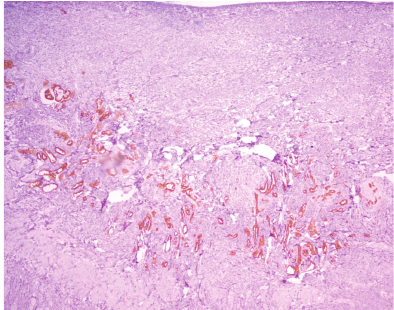
Figure 1: Low-power view of infiltrating malignant mesothelial tubular structures abutting the scrotal wall at the level of tunica dar- tos in close proximity of the epididymis ( × 40 magnification; H&E staining).